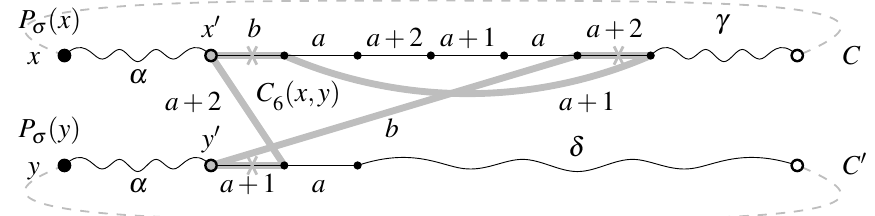
( x , y ) (solid gray) as 6